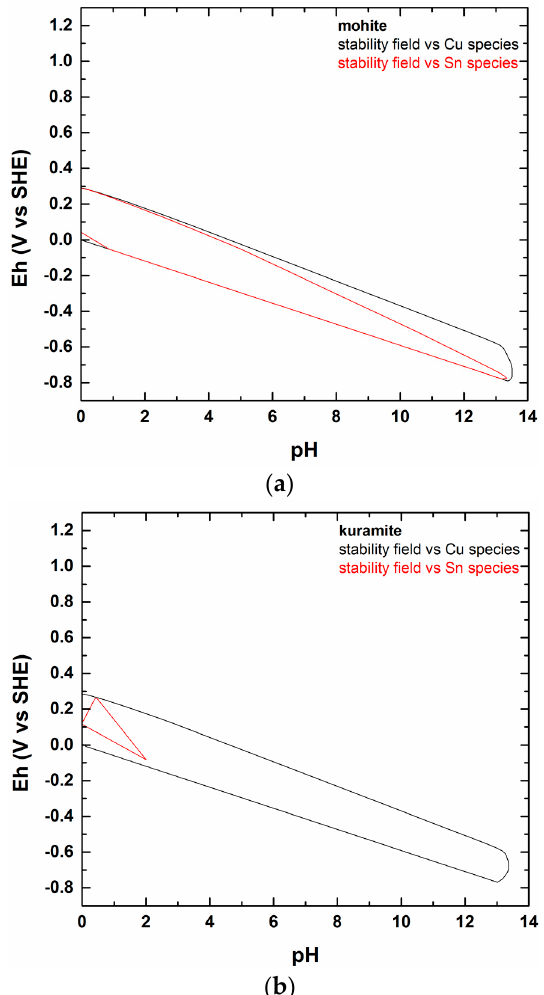
Figure 5. Stability fields for mohite ( a ) and kuramite ( b ) evaluated with respect to the Cu ( black boundaries) and Sn ( red boundaries) species. The calculation conditions are the same of the Figure 5.